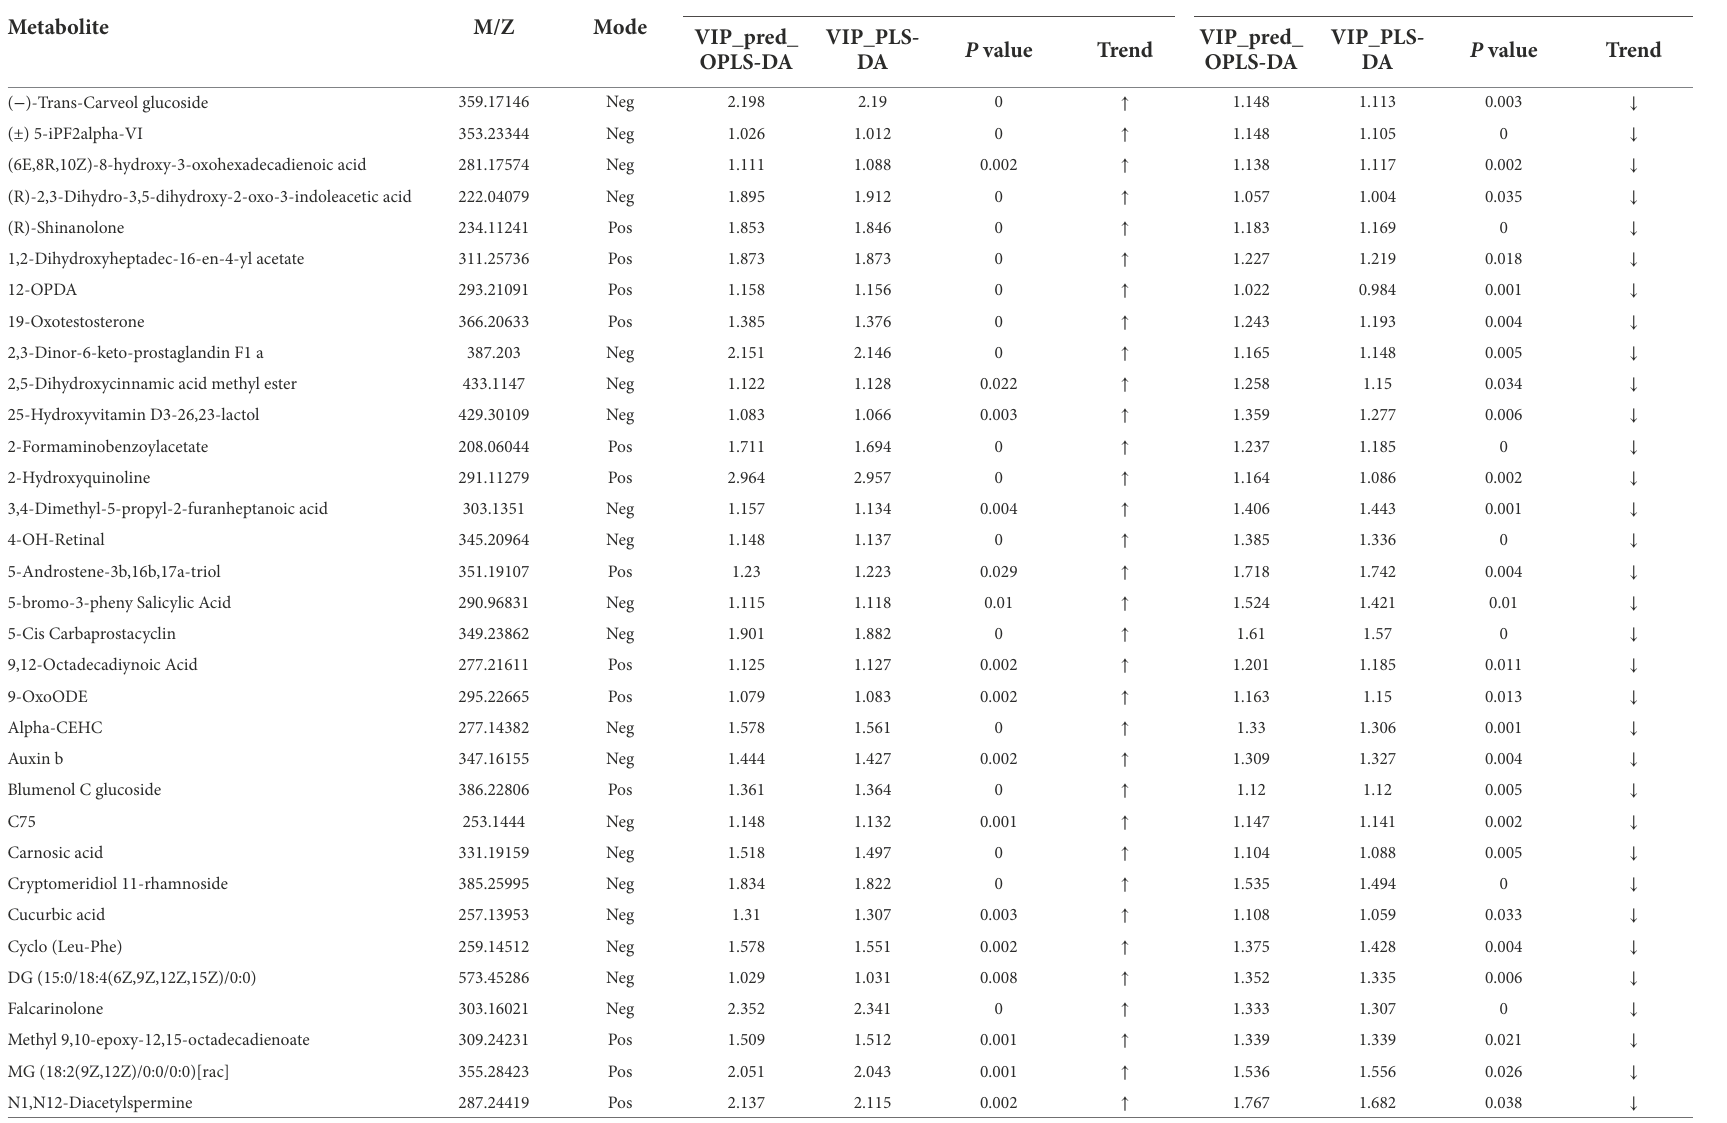
TABLE 1 Potential biomarkers identified in positive and negative ion